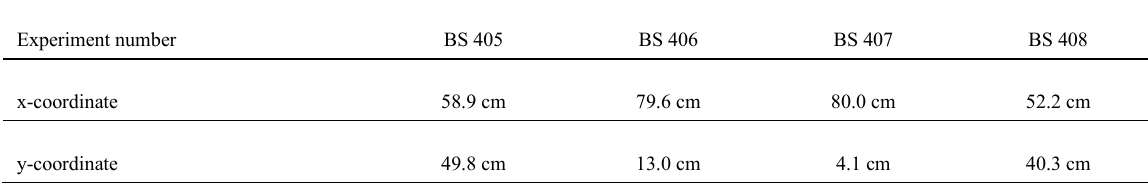
Table 3: Summary of the coordinates of the visually determined locations of crack initiation of tests BS 405 to BS 408. The origin is the lower left corner of the